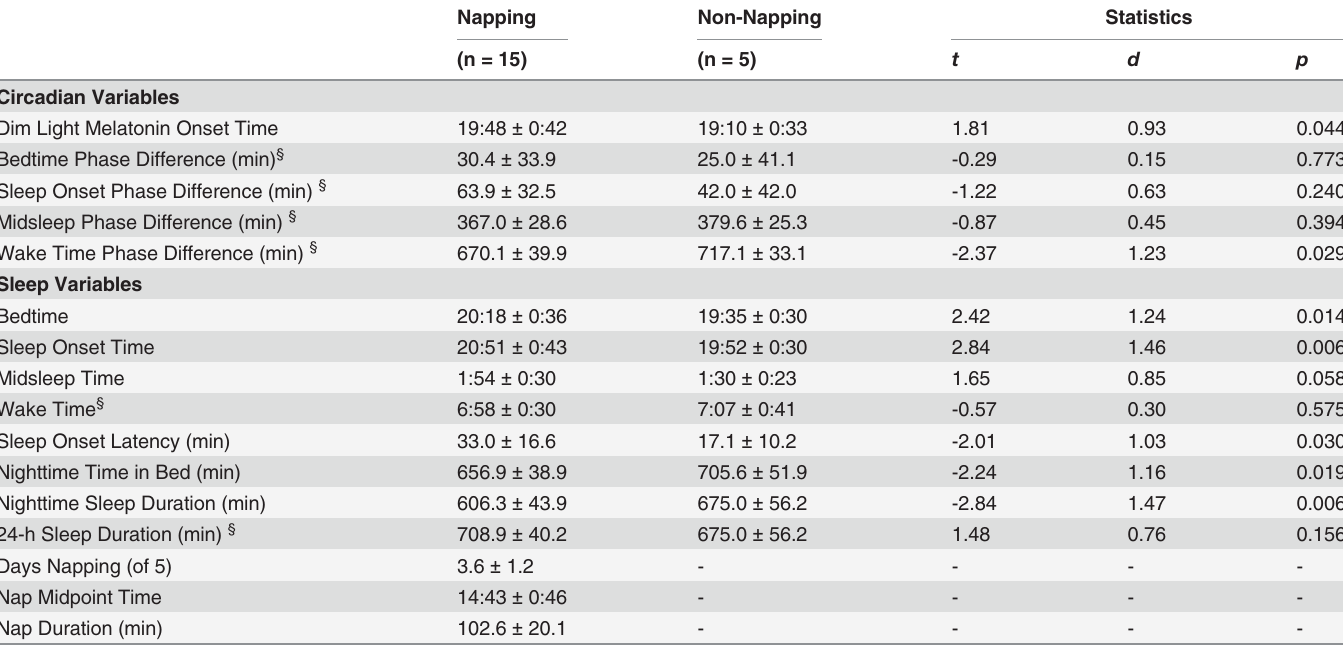
Statistics are shown for independent t-tests (napping versus non-napping participants). § indicates a two-tailed